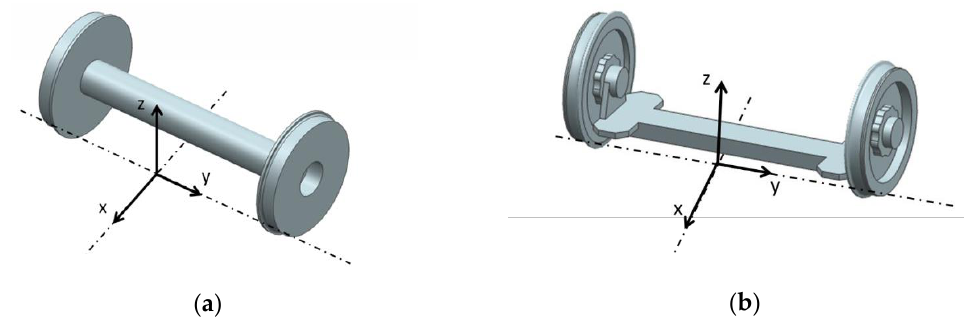
Figure 2. Classic ( a ) and unconventional ( b ) wheelset.